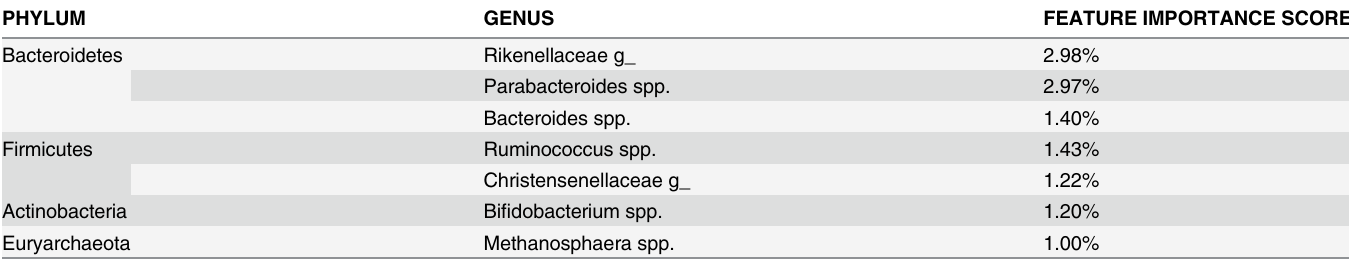
Table 1. Discriminant taxa and respective feature importance scores.